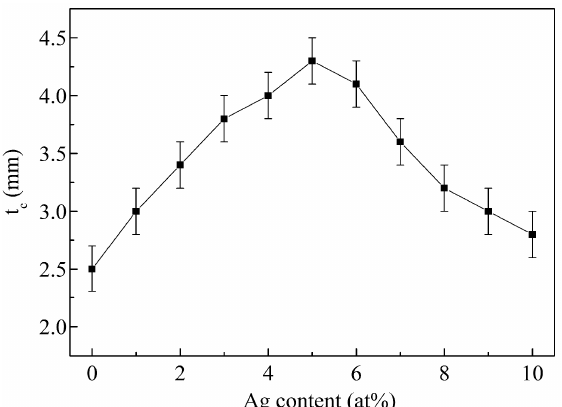
Figure 1. Dependence of maximum thickness of glass phase region ( t c ) on the Ag content in the wedge ‐ shaped samples for the Zr 70 − x Cu 12.5 Ni 10 Al 7.5 Ag x alloys. wedge-shaped samples for the Zr 70 − x Cu 12.5 Ni 10 Al 7.5 Ag x